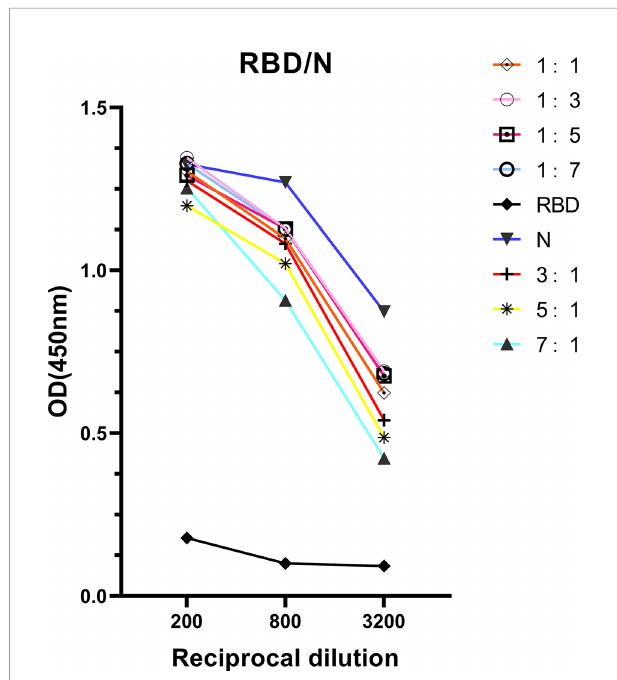
FIGURE 5 | Antigenicity optimization for the combination of RBD protein and N protein. RBD protein was combined with N protein as co-antigen in different proportions at 1:1, 1:3, 1:5, 1:7, 3:1, 5:1, and 7:1,